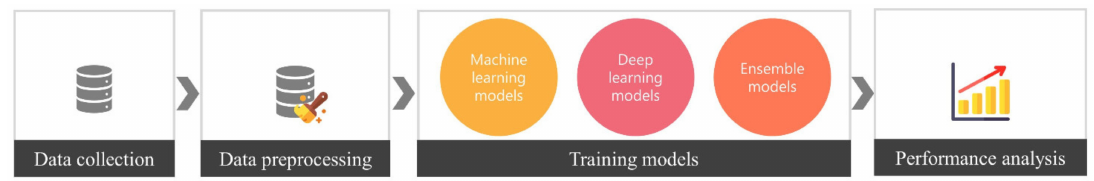
Figure 3. Overview of the analysis procedure.